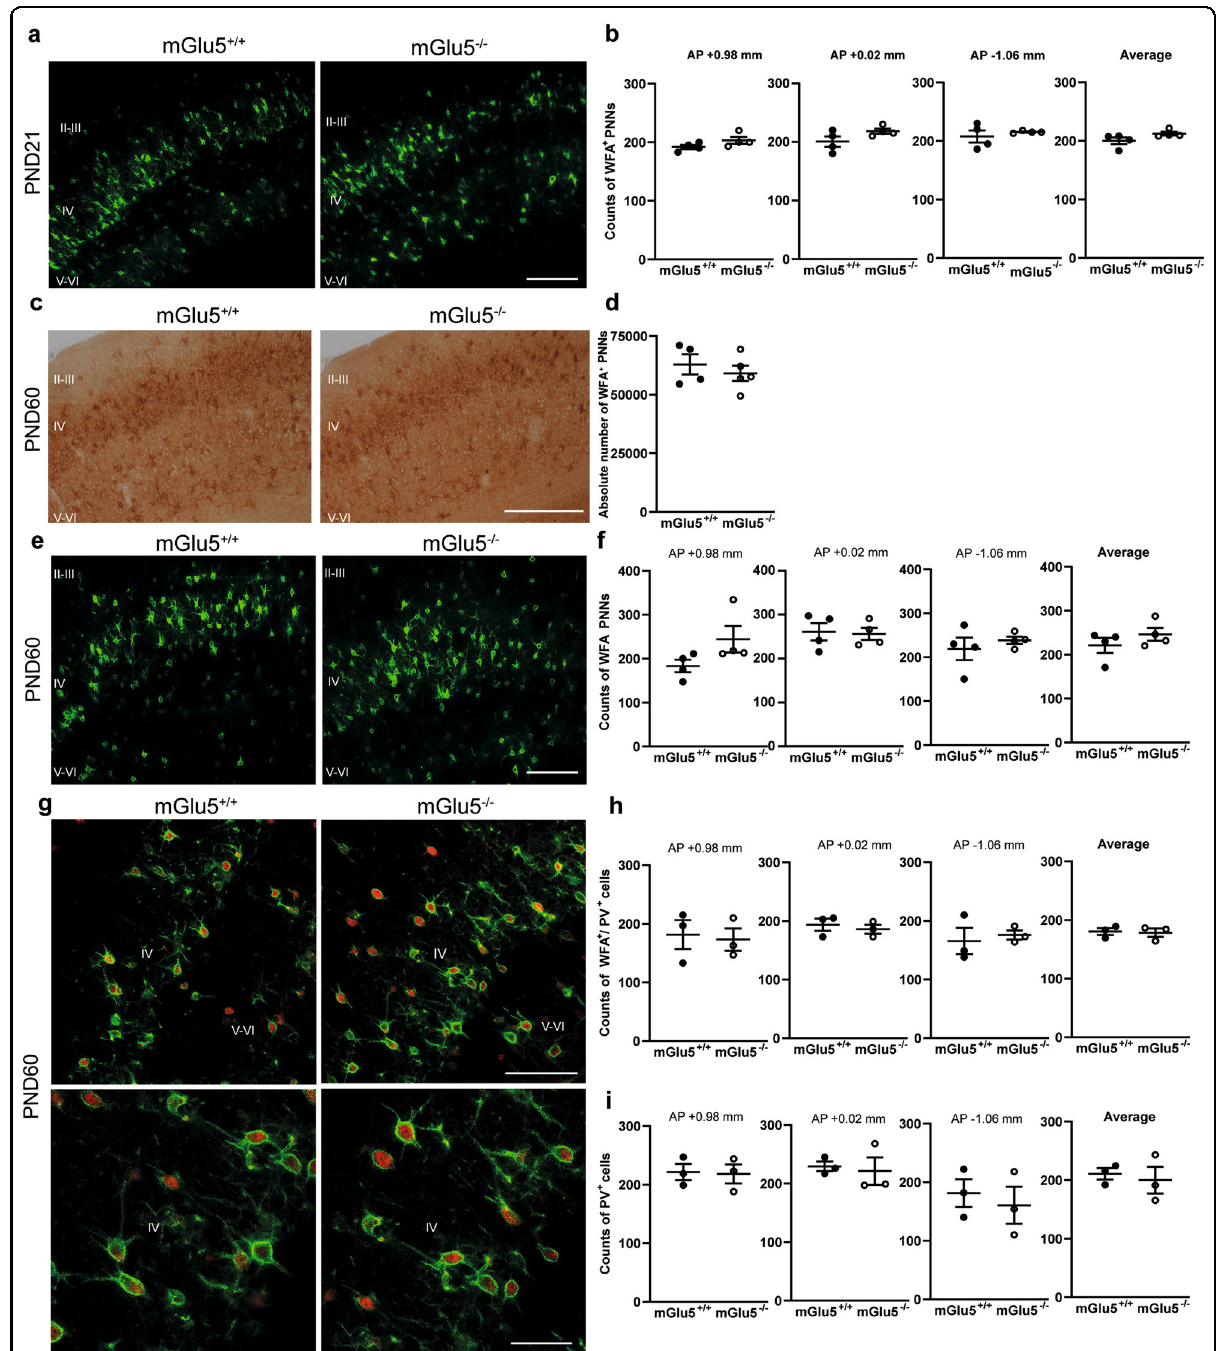
Fig. 2 No difference in WFA + PNNs between mGlu5 − / − and wild-type mice in the somatosensory cortex at PND21 and PND60. a , b WFA +